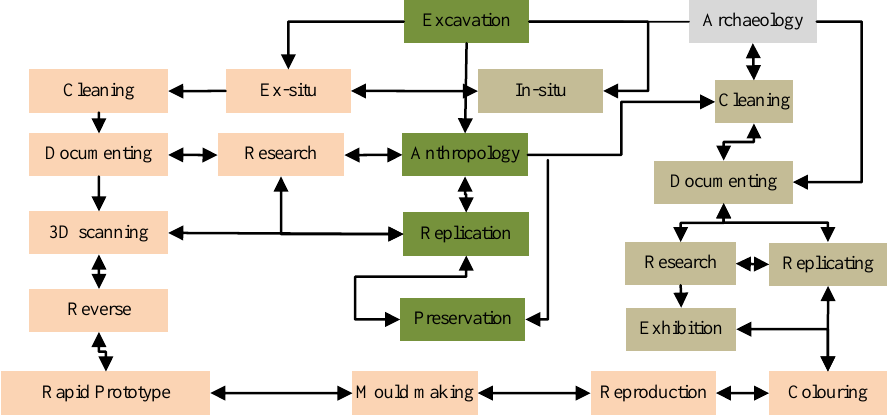
Figure 8. Burial replication and system flow